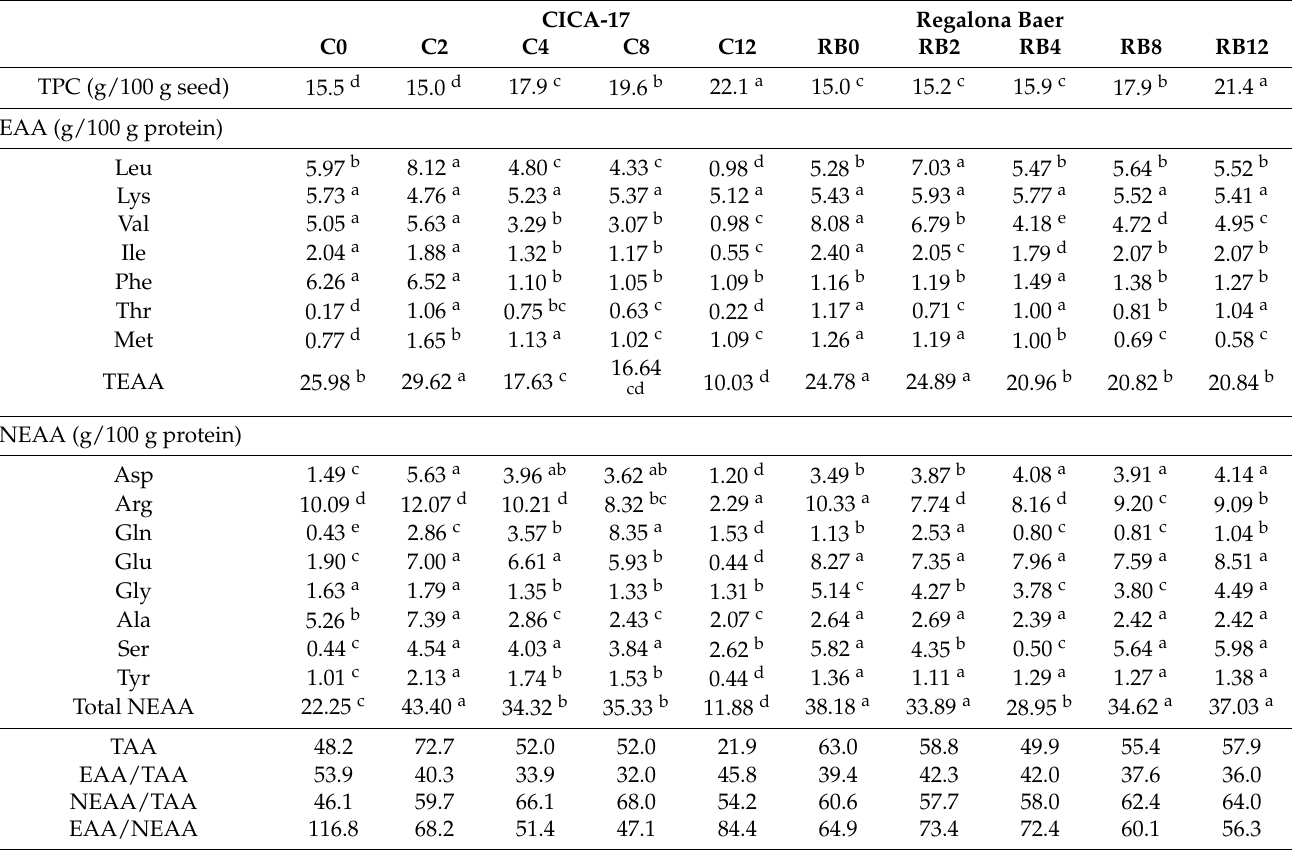
Table 2. Total protein content, essential and non-essential amino acids in CICA-17 and Regalona Baer varieties under different goat manure dose